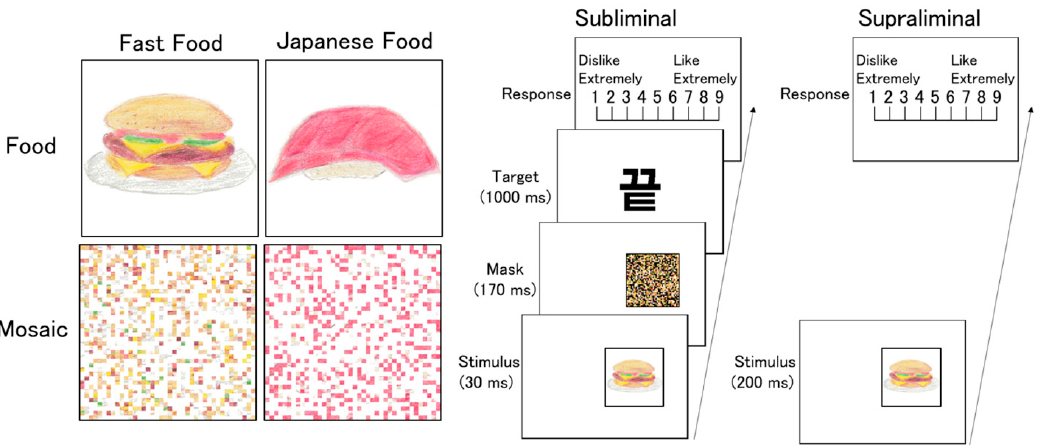
Figure 1. Illustrations of the fast food and Japanese food stimuli ( left ) and the trial sequence ( right ). The experiments employed photographic stimuli.